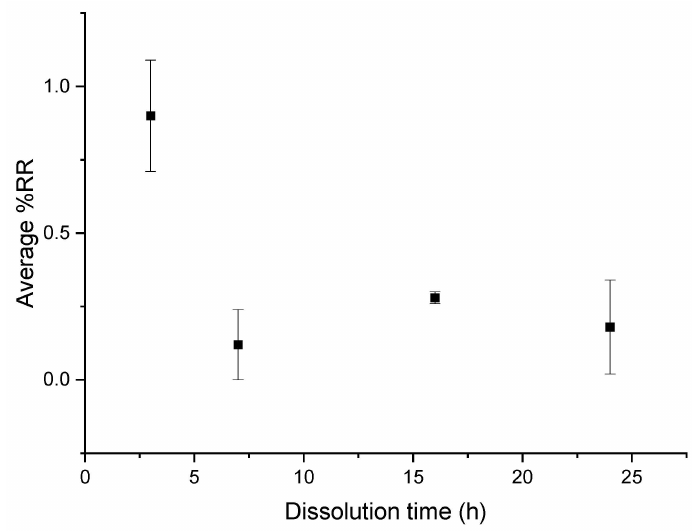
Figure 12. Evolution of the average % RR as a function of time for recycling with mechanical stirring and acetone at a ratio of 1:40.